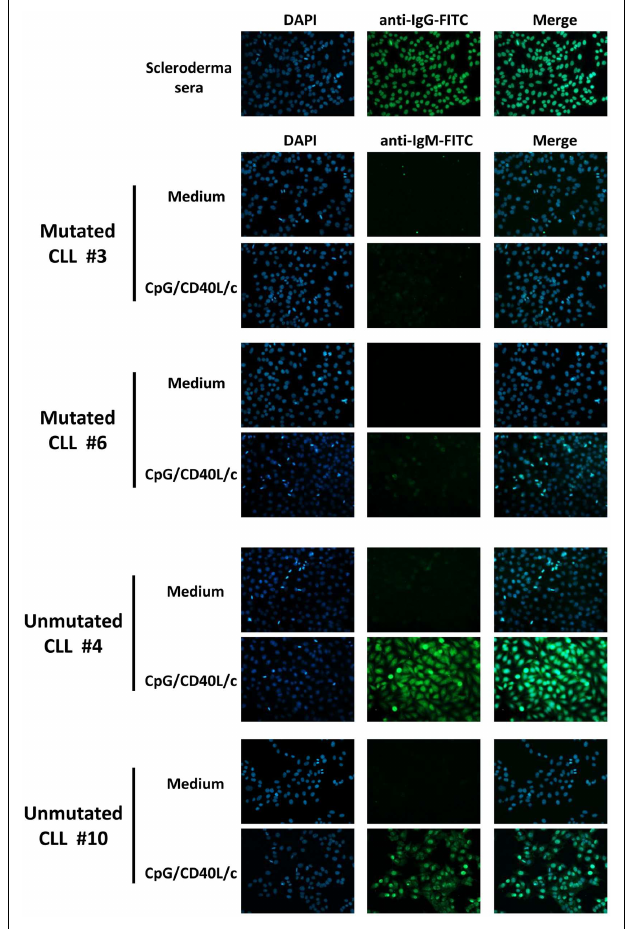
FIGURE 7 | Poly/autoreactivity of secreted IgM, as evaluated by immunofluorescence staining of HEp-2 cells . Day 7 supernatants from six experiments (three mutated CLL samples and three unmutated CLL samples) were tested for reactivity with HEp-2 cells. Serum from scleroderma was used as a positive control for autoreactivity. Indirect immunofluorescence analysis showed that the IgM secreted into the culture supernatant by ASCs having differentiated from unmutated CLL B-cells were able to bind to autoantigens in HEp-2 cells. Magnification: ×